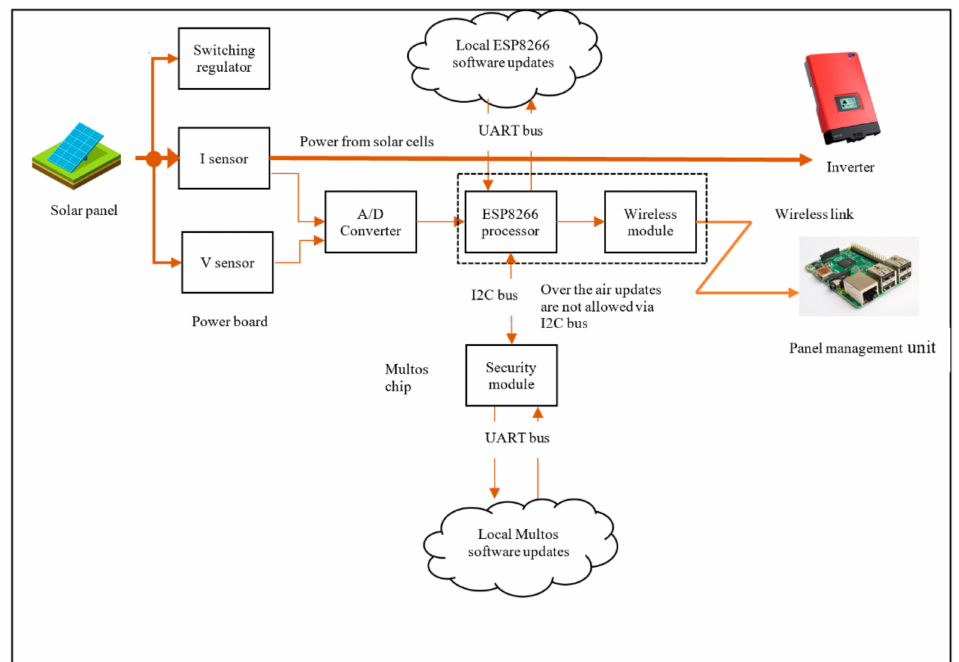
Figure 8. System level architecture showing the communication